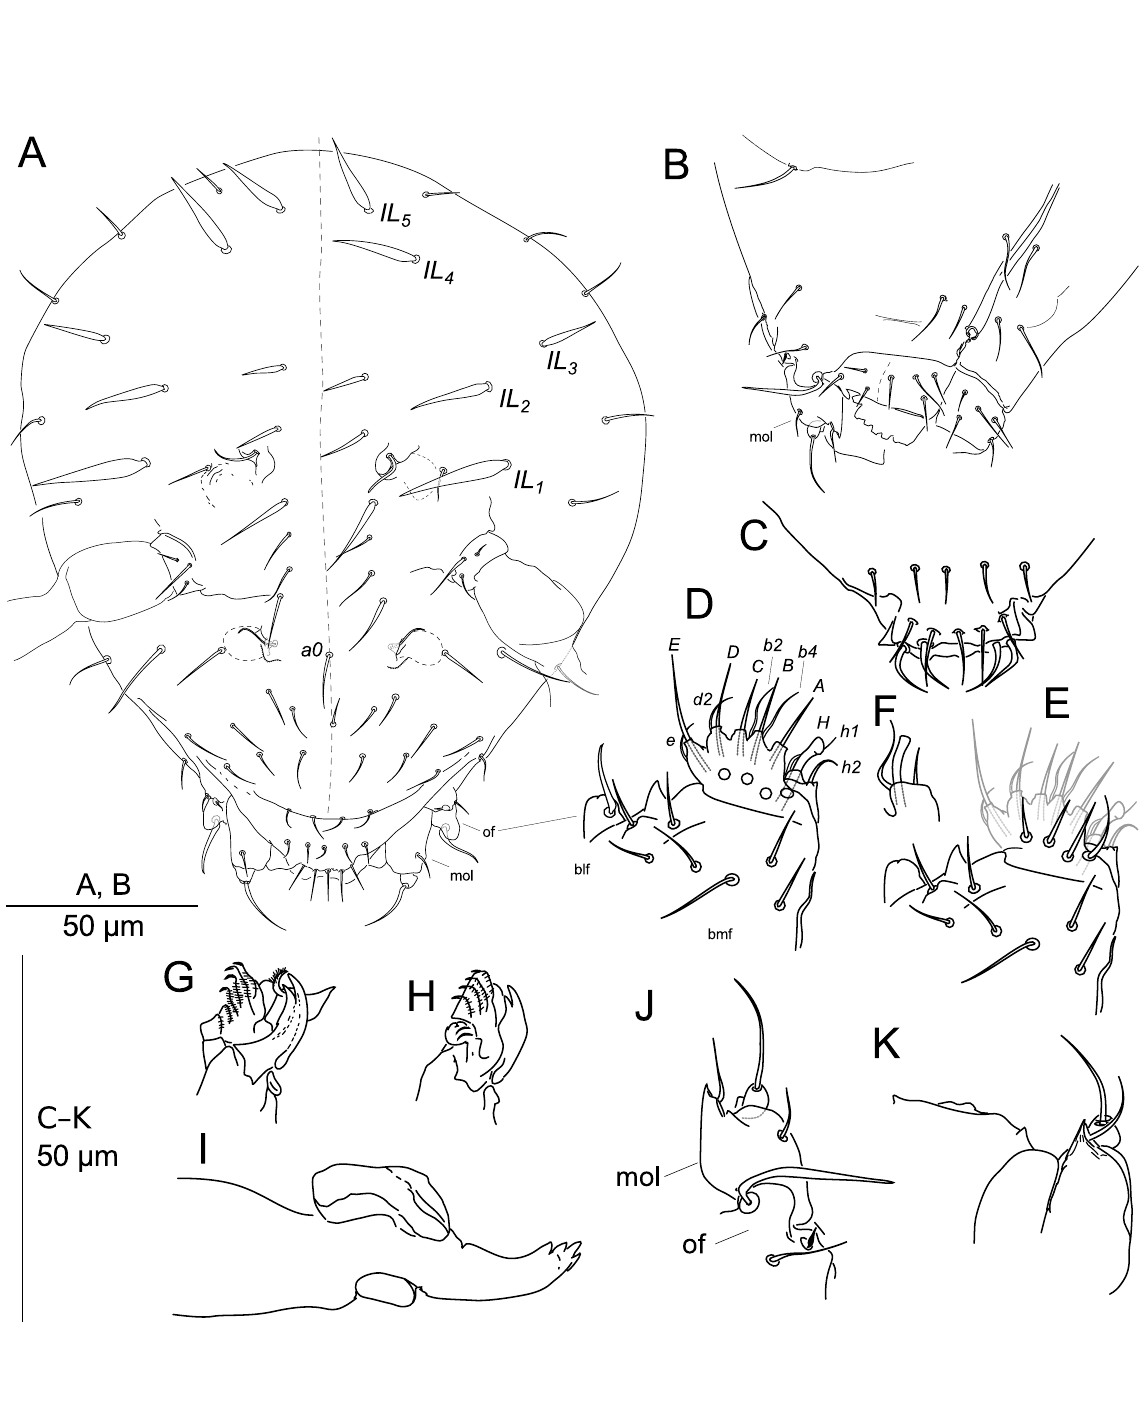
Fig. 2. Spinaethorax adamantis sp. nov. A–B . Chaetotaxy of the head. A . Dorsal side. B . Ventral side, anterior part. C . Labrum dorsal side. D–F . Labium. D . Focus on papillate chaetae of the palp. E . Focus on chaetae in proximal field. F . focus on papilla H . G–H . Maxilla, different views. I . Left mandible. J–K . Maxilla outer lobe. J . Lateral side. K . Ventral side. Abbreviations: blf = basolateral field of labium; bmf = basomedian field of labium; mol = maxilla outer lobe; of = oral fold. Labial palp lettering after Fjellberg